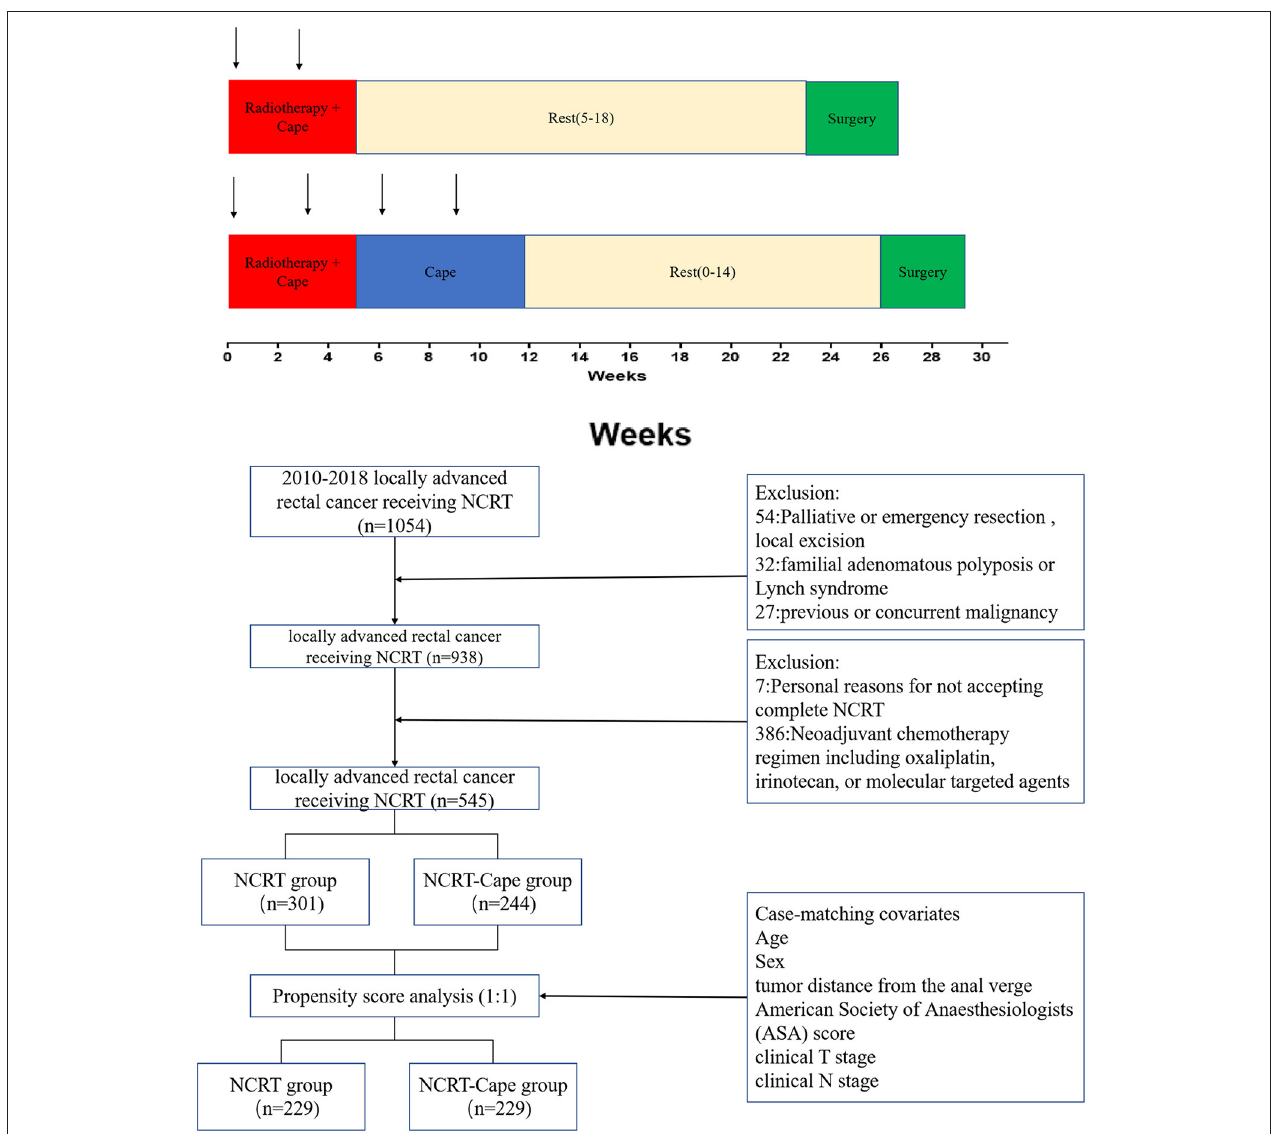
FIGURE 1 | The protocol of the neoadjuvant chemoradiotherapy in the two groups. NCRT, neoadjuvant chemoradiotherapy; NCRT-Cape, neoadjuvant chemoradiotherapy, and additional capecitabine